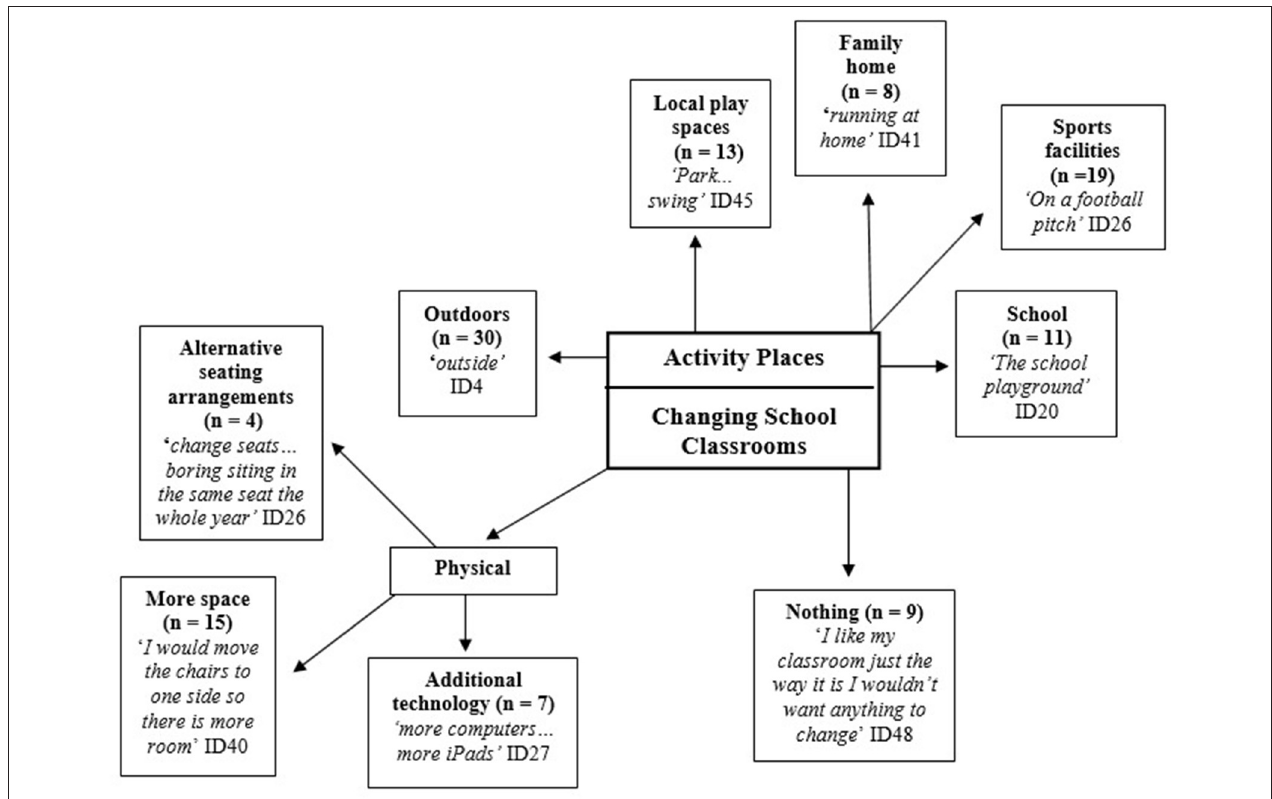
FIGURE 3 | Write and draw